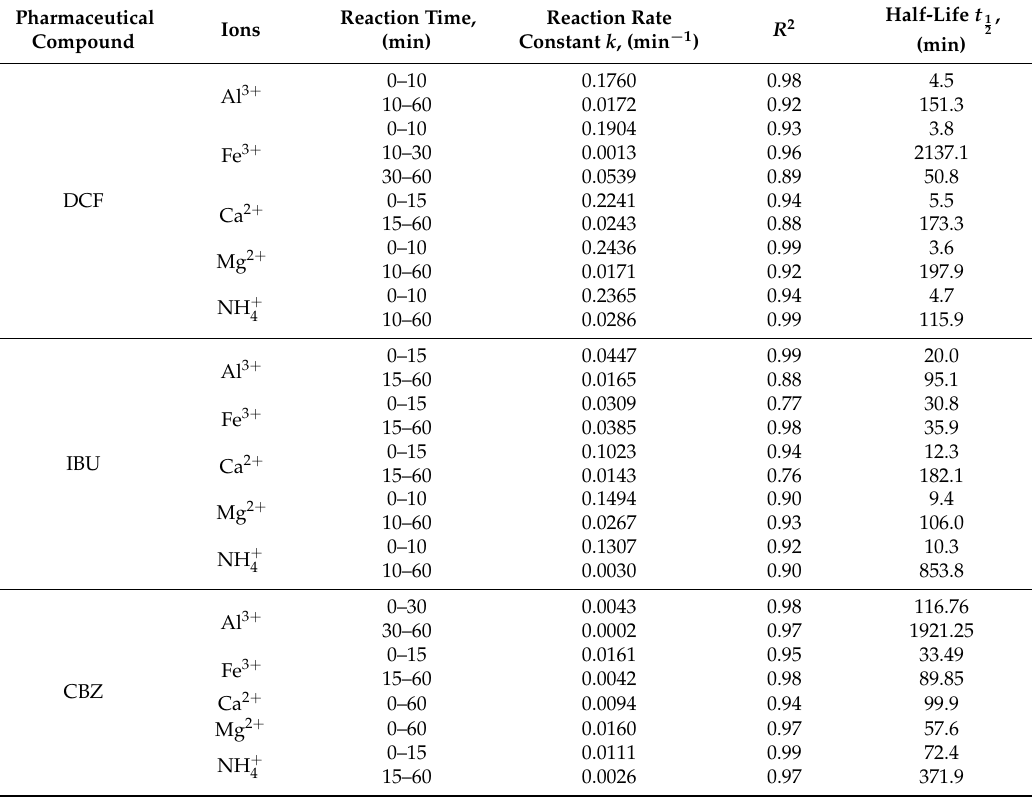
Table 4. Half-life of investigated pharmaceutical compounds during photocatalysis in the presence of selected